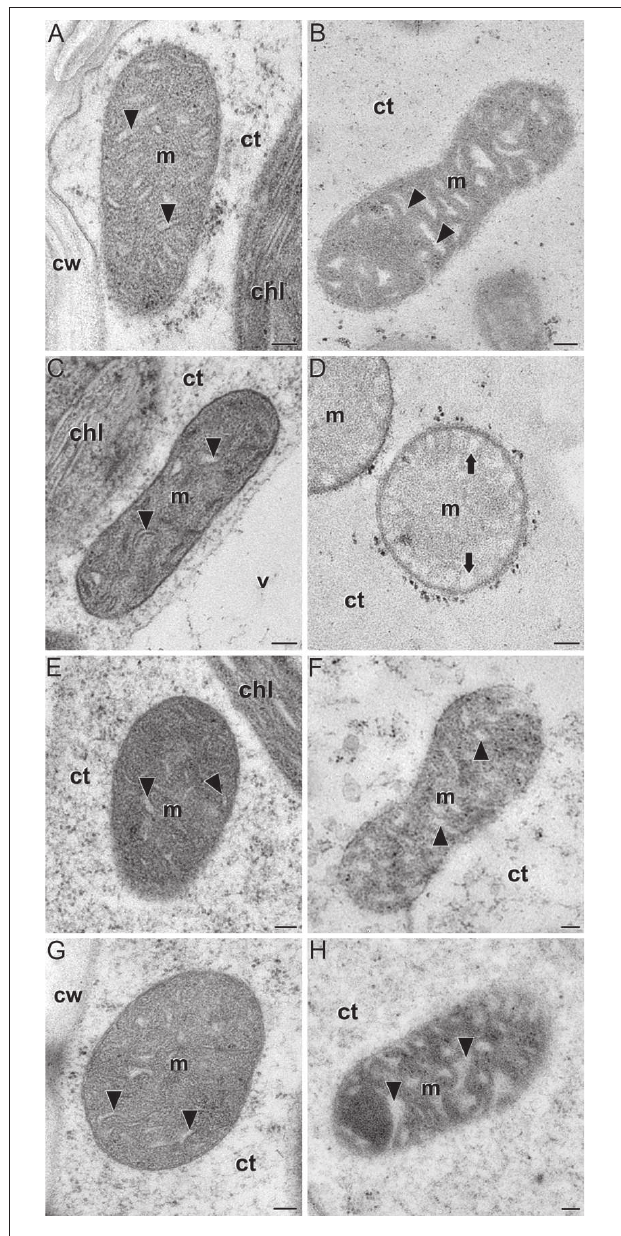
FIGURE 8 | Ultrastructure of mitochondria (m) in leaves (A,C,E,G) and 24 DAP endosperms (B,D,F,H) of WT (A,B) , Zmbt1-1 (C,D) , Sh2 (E,F) , and Zmbt1-1::MitTPr- 1 TP-ZmBT1-1(1) seeds (G,H) . Arrowheads point to mitochondrial cristae. Note their absence in (D) , where only round, peripheral invaginations (arrows) are observed. chl, chloroplast; ct, cytoplasm; cw, cell wall; v, vacuole. Bars: